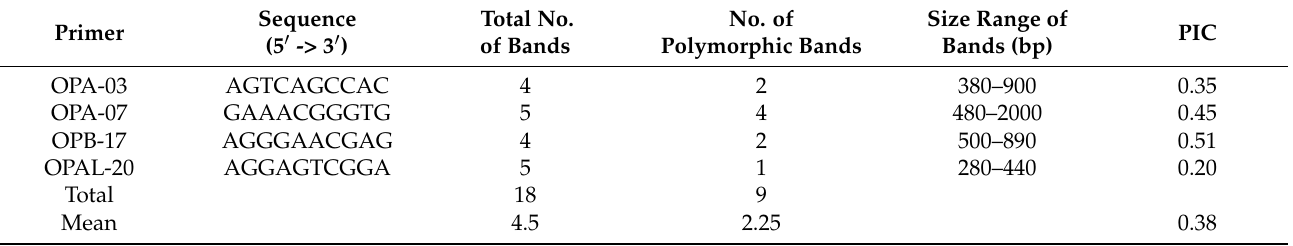
Table A4. RAPD primers and acquired results from each primer. PIC—polymorphic information